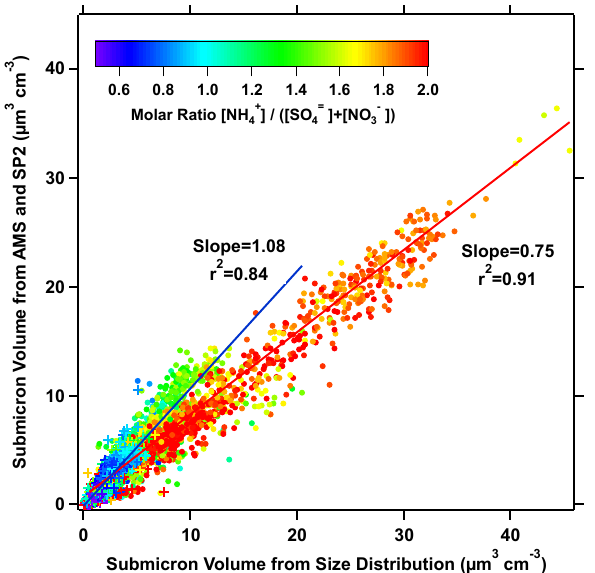
Fig. 4. Submicron dry particle volume determined from AMS and SP2 speciated mass measurements. Dots were acquired in BB plumes; crosses were acquired in anthropogenic plumes and background and sea-ice boundary layer conditions. Symbols color- coded by the measured molar ratio of NH + Lines are fits to data with F mr ≥ 1.5 (red line) and < 1.5 (blue line).